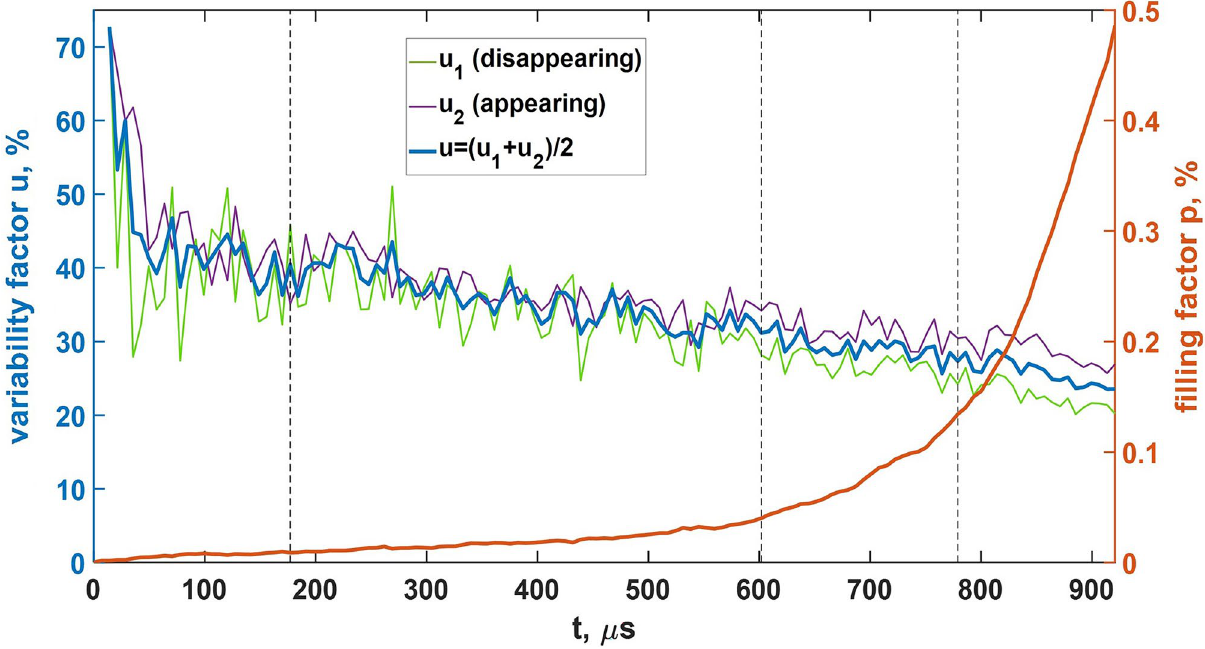
Figure 13. Temporal evolution of filling p and variability u factors reflecting dynamics of the self-organizing streamer/leader discharge system. Parameters u 1 and u 2 stand for the relative share of links disappearing and arising each time iteration, respectively, while the parameter u is their arithmetical mean. All the presented quantities are calculated not for the entire model volume, but for the horizontally reduced rectangular 20 x m 20 and 20 y m 10 , which includes the vast majority of model links parallelepiped with − ≤ [ ] ≤ − ≤ [ ] ≤ during the entire simulation time (see Fig. 10). Vertical dotted lines correspond to the moments of time shown in panels ( a–c ) in Fig.